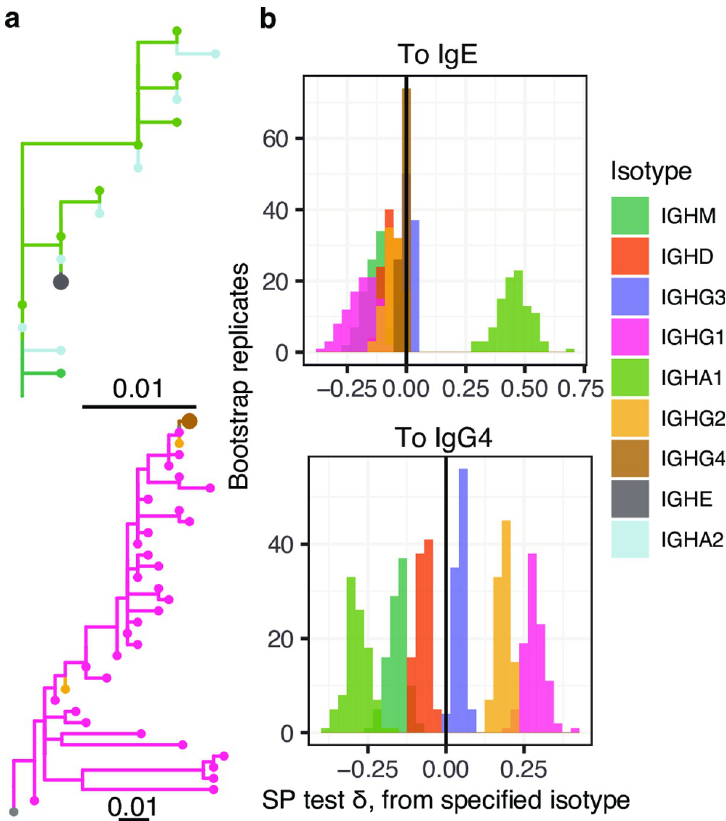
Fig 6. Analysis of antibody isotypes from a single subject. (a) Example trees visualized using ggtree [38,39] showing observed relationships between cells expressing BCRs with IgA1 and IgE, as well as IgG1 and IgG4 isotypes. IgE and IgG4 are indicated on each tree using larger tip circles. (b) Distribution of SP test δ values to IgE from each of the other isotypes (different colors), and distribution of SP test δ values to IgG4 from each of the other isotypes (different colors). State changes in b were calculated using constrained parsimony which forbids state changes that violate the geometry of the Ig heavy chain locus, and SP tests were performed using permutation among trees.